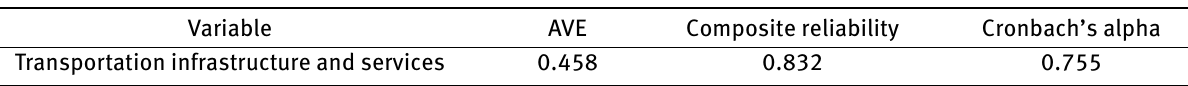
Table 5: Latent variable coeflcients for the reflective